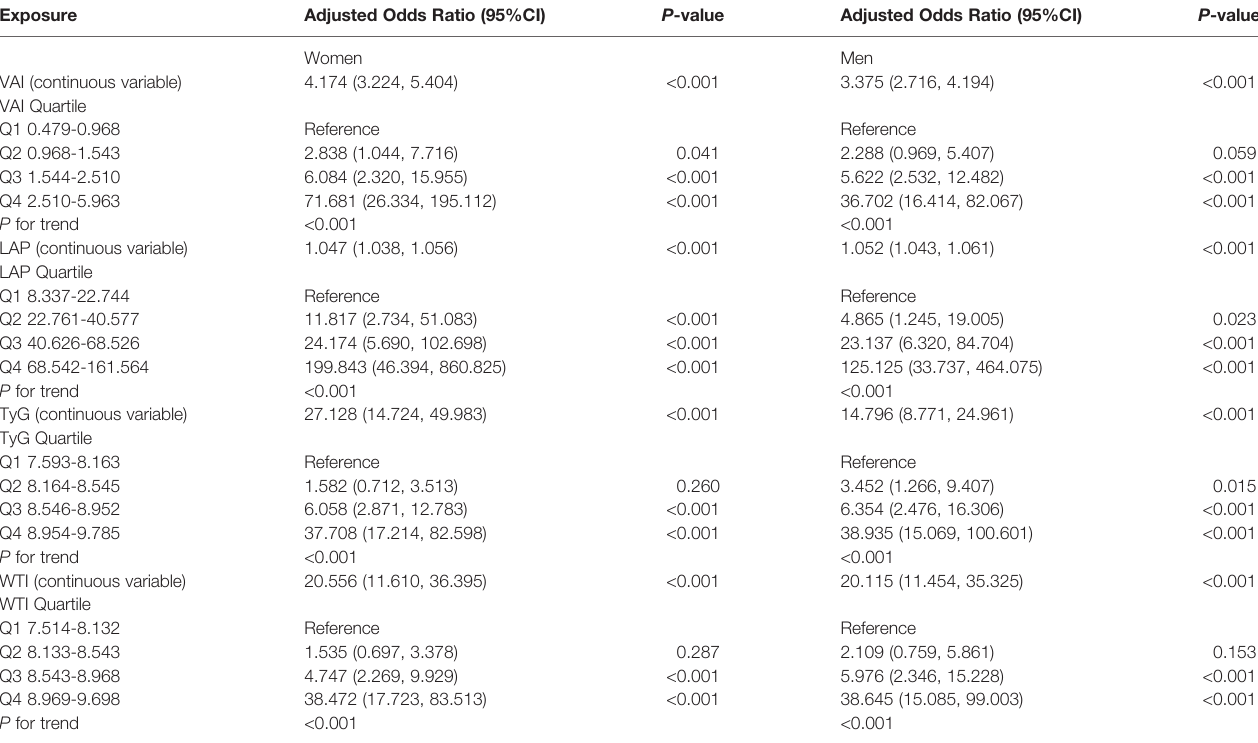
TABLE 4 | Associations between MetS and LAP, VAI, TyG and WTI.